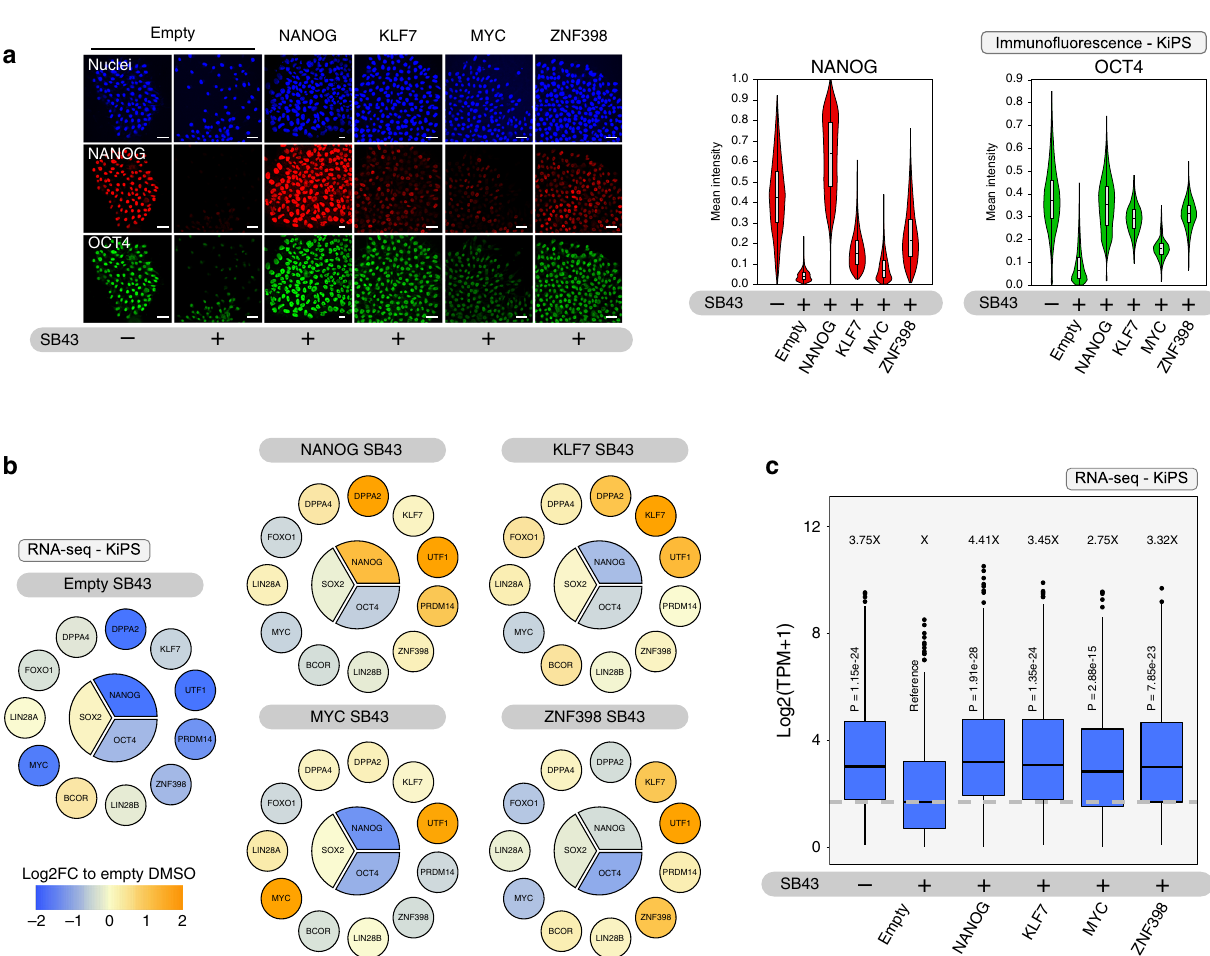
Fig. 4 A quartet of transcriptional regulators maintain pluripotency. a Left: immunostaining for the pluripotency markers NANOG and POU5F1/OCT4 of KiPS stably expressing an empty vector control (Empty) in presence of DMSO or SB43 and KiPS stably expressing NANOG, KLF7, MYC or ZNF398 in presence of SB43 for 5 days. Representative images of three independent experiments are shown. Right: Violin plots showing fl uorescence intensity quanti fi cation of NANOG and OCT4. For each condition, at least 1200 nuclei from fi ve randomly selected fi elds were analysed. Box plot indicates 25th, 50th and 75th percentile; whiskers indicate minimum and maximum. Scale bars 20 µ m. See also Supplementary Fig. 3c for results obtained in H9. Source data are provided as a Source Data fi le. b Diagrams showing an extended set of pluripotency regulators. Gene expression analysis by RNA-seq of KiPS stably expressing an empty vector, NANOG, KLF7, MYC or ZNF398 and treated with SB43 for 5 days. Colours indicate the fold-change relative to Empty DMSO sample, thus yellow indicates the endogenous expression of a given gene in undifferentiated hPSCs. c Box plot showing absolute expression levels (normalised counts, TPM) of 538 genes DOWN-regulated by SB43 treatment (5 days) in KiPS stably expressing an empty vector (see Fig. 5a, blue dots). Shown data refers to KiPS transfected with the empty vector in the presence of DMSO or SB43 ( n = 4, 4 independent experiments, respectively) and for KiPS stably expressing NANOG, KLF7, MYC or ZNF398 in presence of SB43 for 5 days ( n = 2, 2, 2, 2 independent experiments, respectively). Average fold-change relative to Empty SB43 sample ( X ) is reported for each condition. Box plots indicate 25th, 50th and 75th percentile; whiskers indicate minimum and maximum. Unpaired two-tailed t